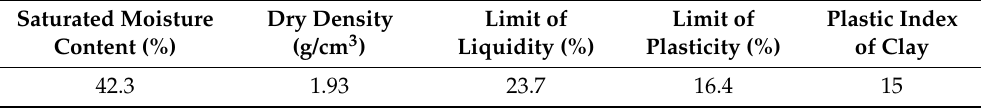
Table 1. Physical properties of the tested soil